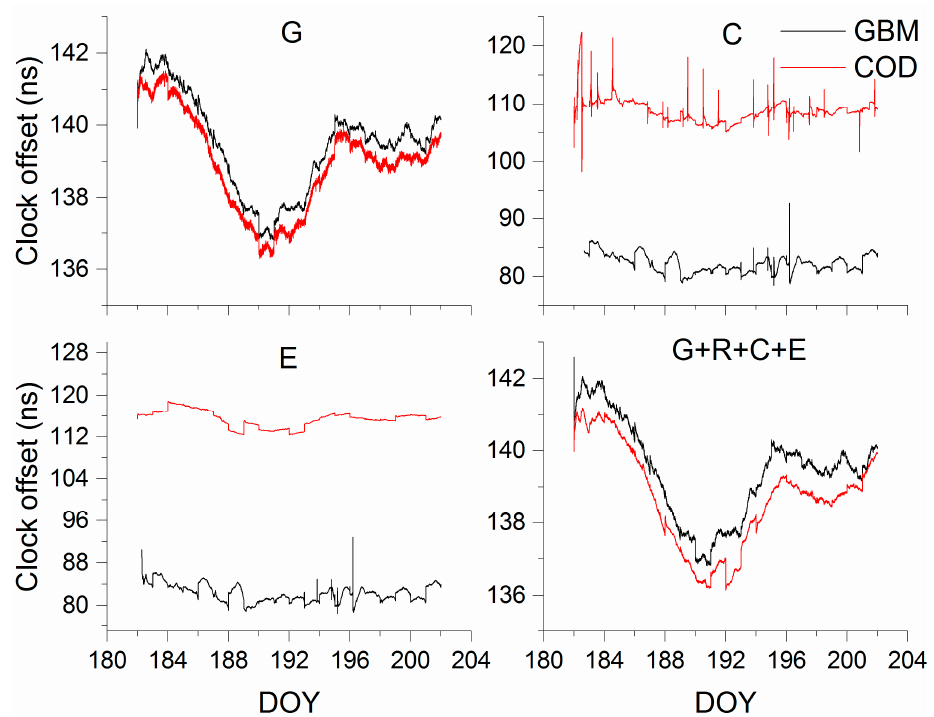
Figure 2. Clock offset in single-system and multi-GNSS models on BRUX using COD and GBM products.